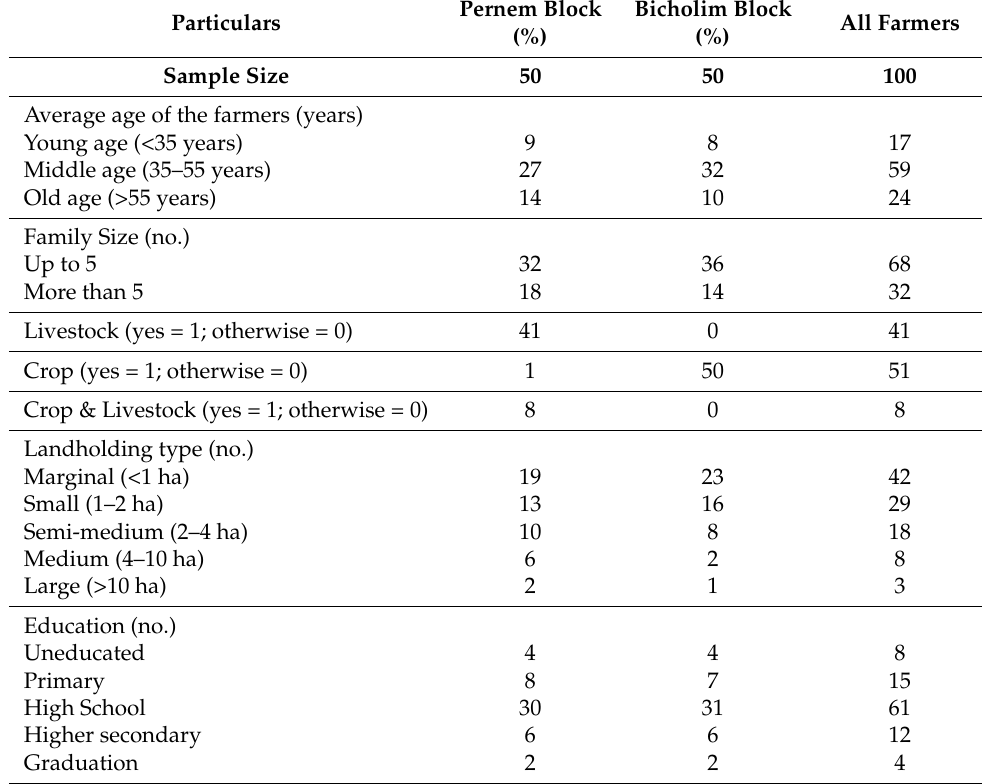
Pernem Block Bicholim Block All Farmers (%) (%)